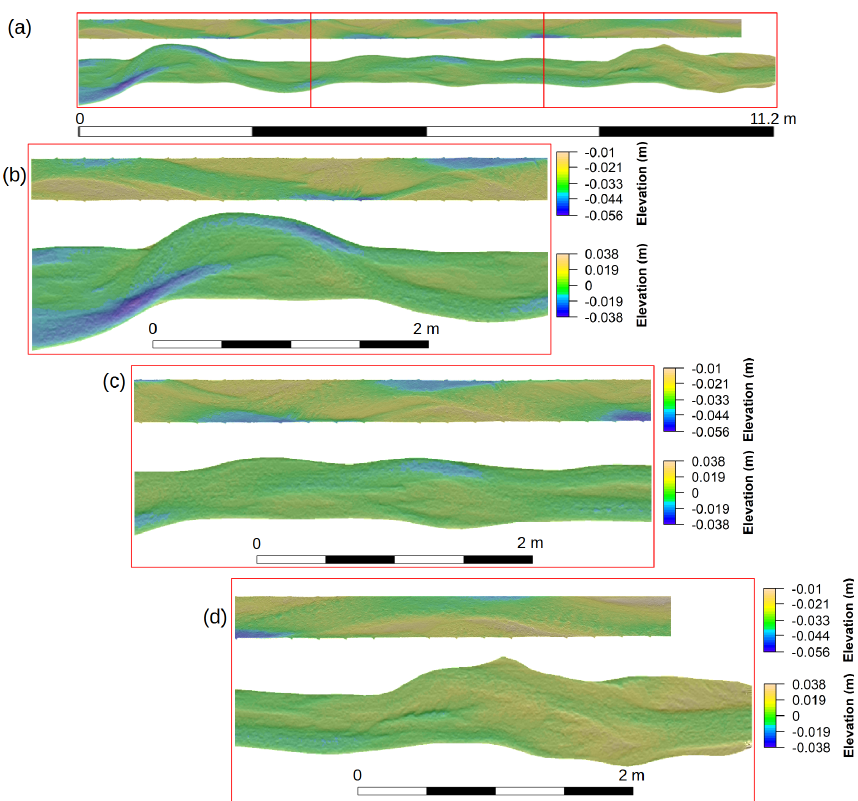
Figure 3. DEMs from the final scan of the fixed-bank (upper) and mobile-bank (lower) experiments. Panel (a) shows the full extent of the DEMs; differences in length result from data collection methodologies. Inset panels show enlarged sections of the (b) downstream, (c) middle, and (d) upstream sections of the bed surface. Flow is from right to